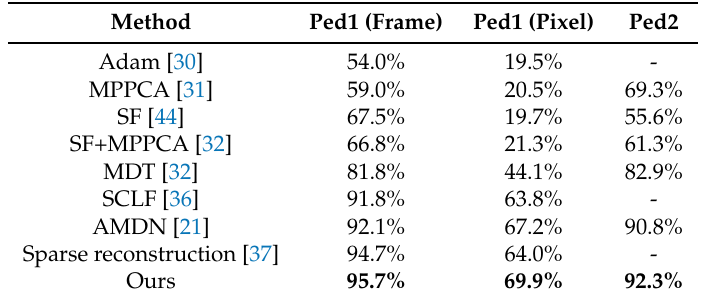
Table 1. Area under curve (AUC) comparison with the state of art methods.